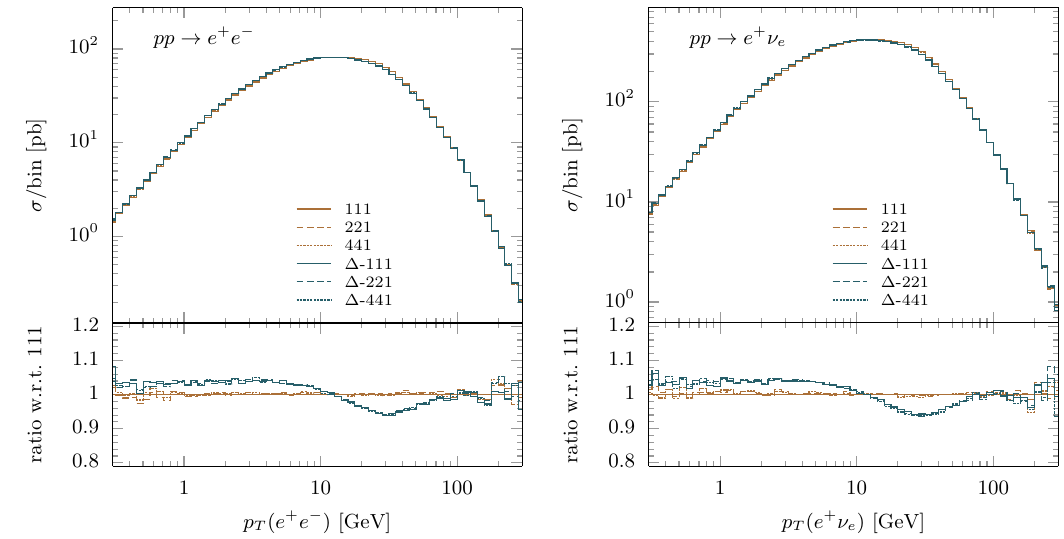
Figure 2 . Transverse momentum of the e + e (cid:0) pair (left panel) and of the e + (cid:23) for the process in eqs. (5.7) and (5.8), respectively. Both MC@NLO (brown histograms) and MC@NLO-(cid:1) (blue histograms) results are shown, for three choices of folding